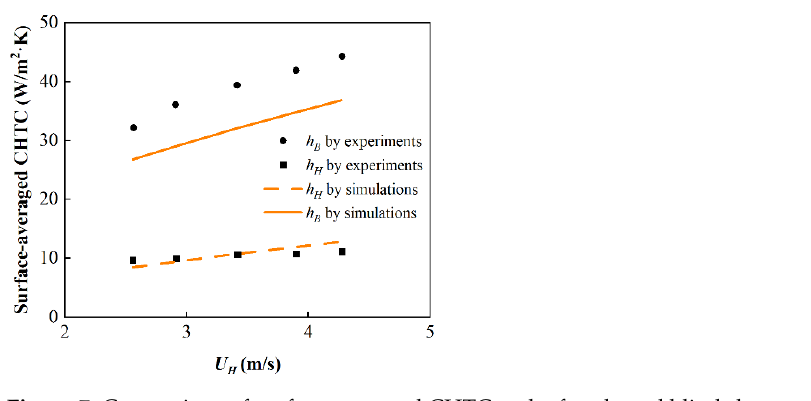
Figure 7. Comparison of surface-averaged CHTC at the façade and blinds between experiments and simulations ( B = 0.035 H , W = 0.05 H , θ = 45°, φ = 0°, T H − T a = 10 °C, T B − T a = 20 °C).